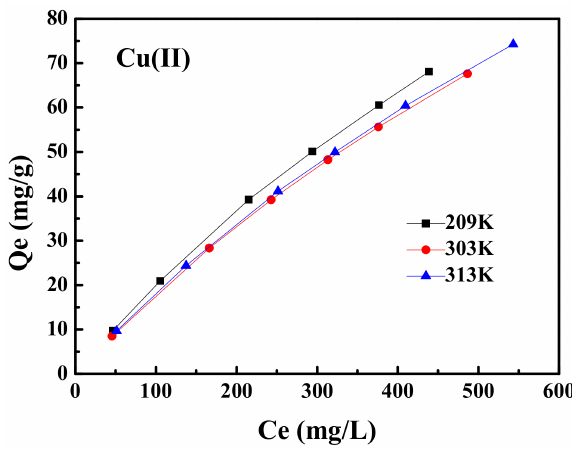
Figure 8. Effect of temperature on the adsorption.